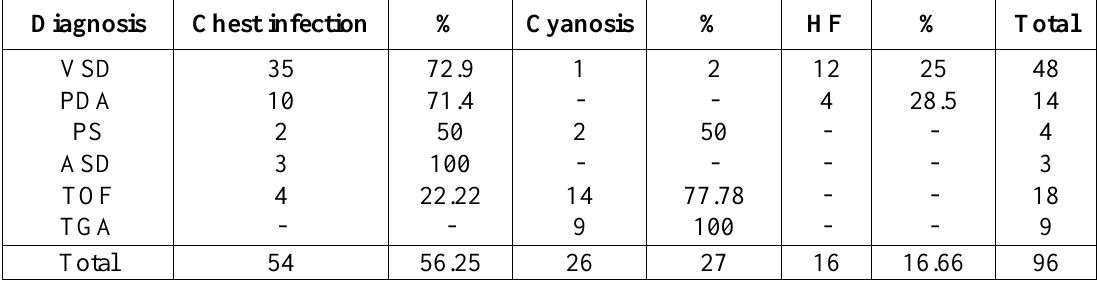
Table 5: Common presentation of various types of